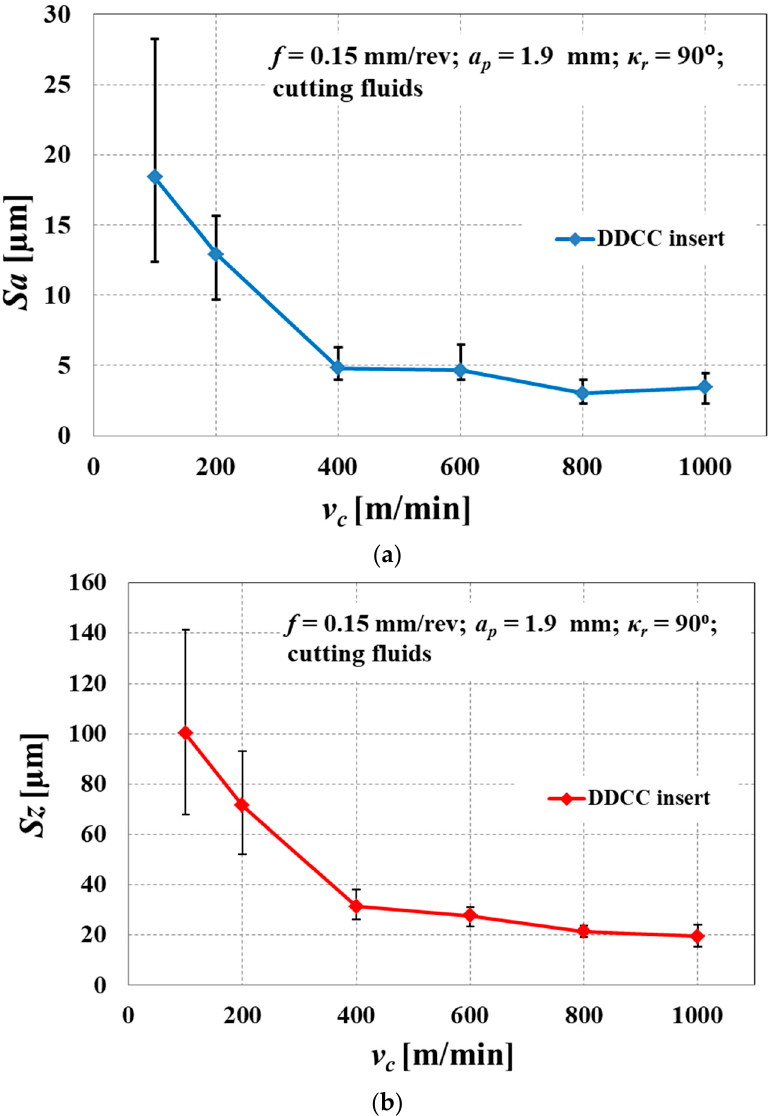
Figure 15. The influence of cutting speed on surface roughness of AlSi13MgCuNi alloy during grooving with a DDCC insert: ( a ) Sa parameter; ( b ) Sz parameter.